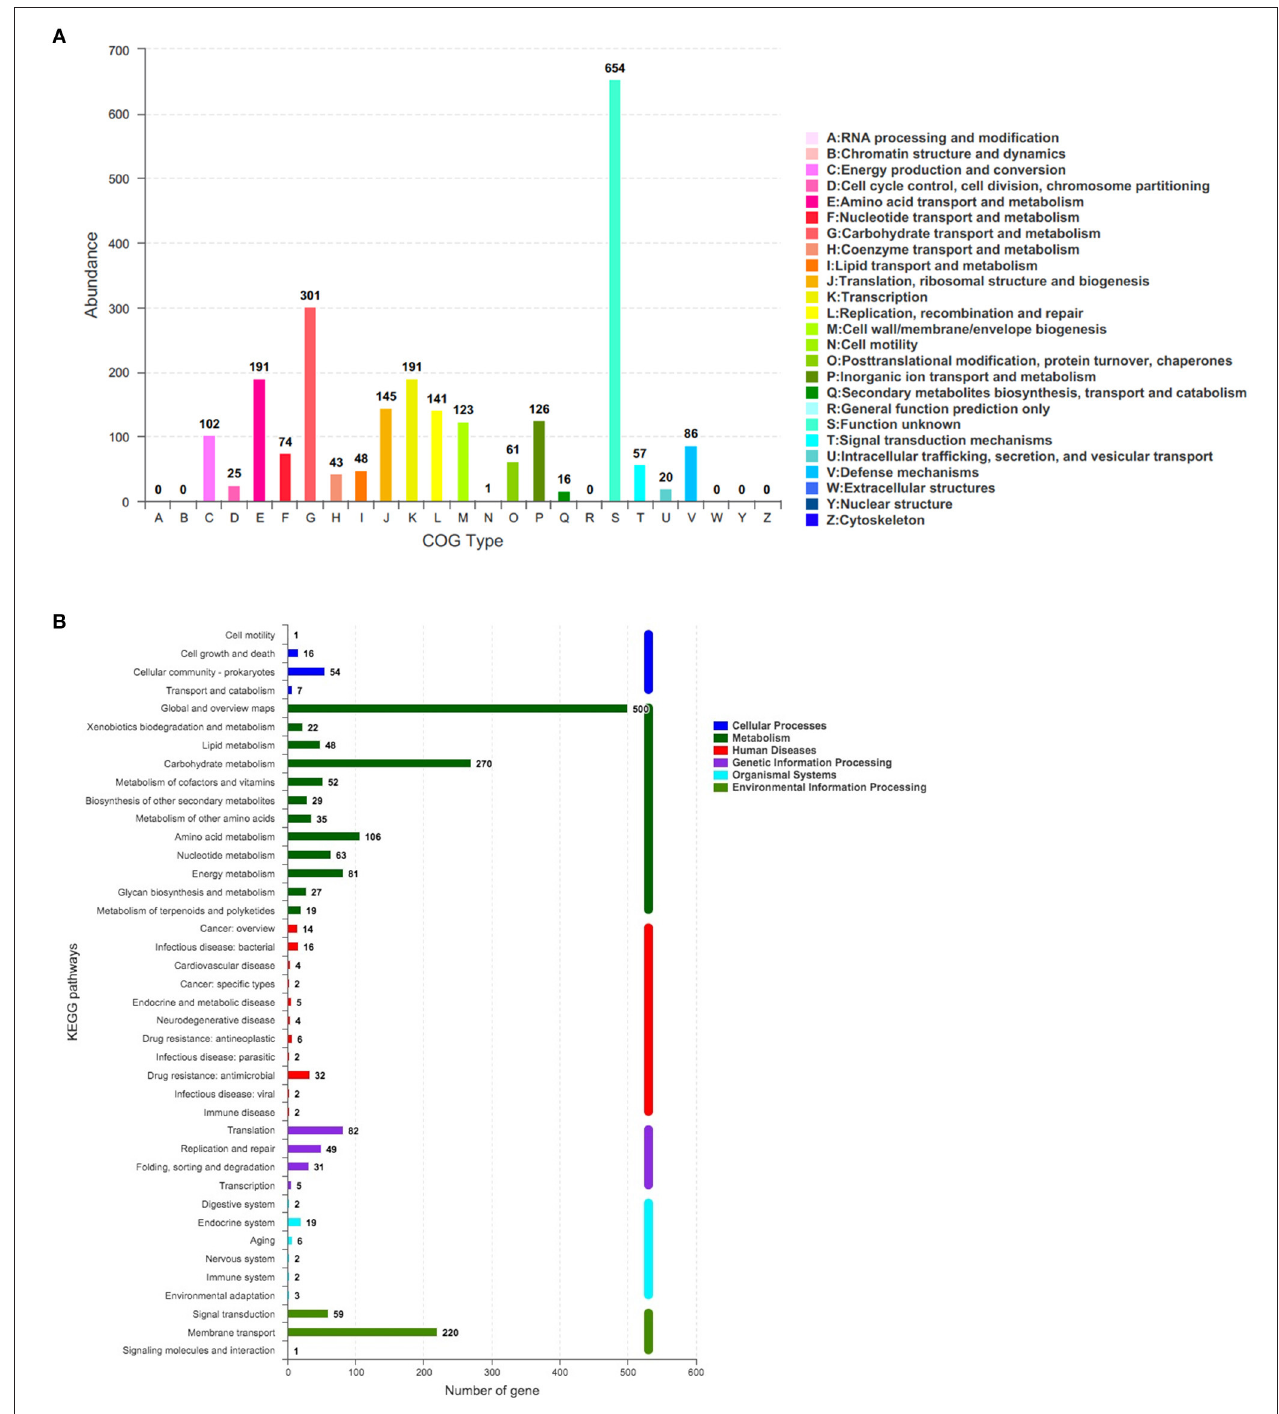
FIGURE 5 | The number of genes assigned to COGs (A) and KEGG (B) function categories in the genome of L. paracasei YT170. COGs, Clusters of Orthologous Groups (COGs) database; KEGG, Kyoto Encyclopedia of Genes and Genomes (KEGG) database.